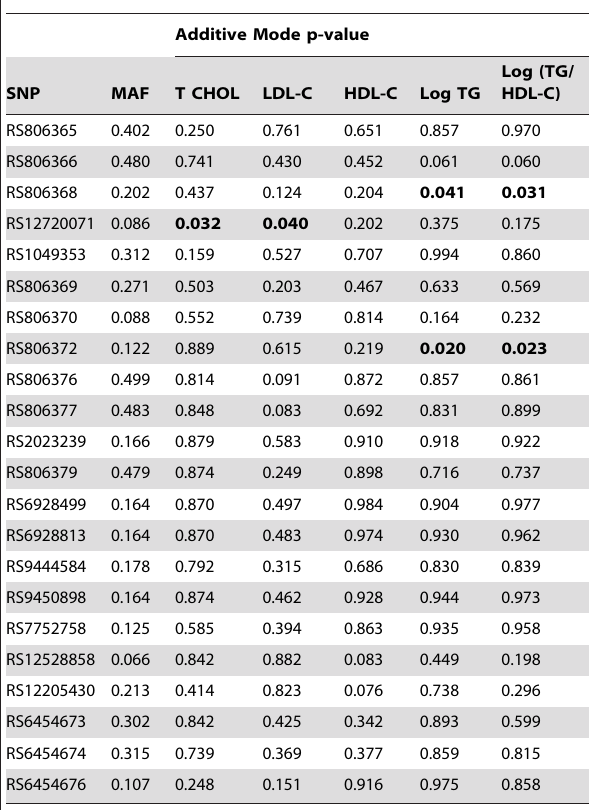
Table 4. Association between median lipid traits and single SNPs, using an extended region of interest (p-values from a linear regression model in PLINK).